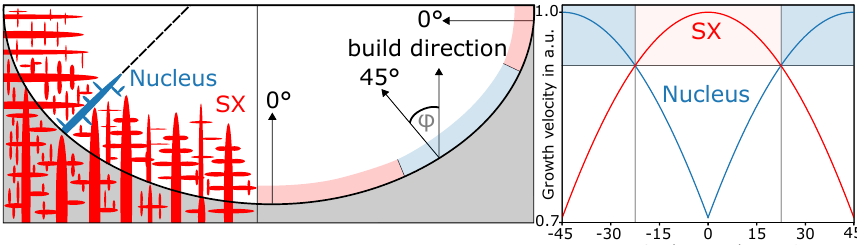
Figure 4. Melt pool of Sample 3 from Figure 3b with nucleation at melt-pool border shown as SEM image and electron-backscattered-diffraction (EBSD) overlay. For convenience, single crystal (SX) signal was deleted, and only new grains are shown in EBSD. In the underlying SEM image, new grains were manually highlighted for comparison with the EBSD signal. On the basis of the SEM image, the melt-pool border was inserted.